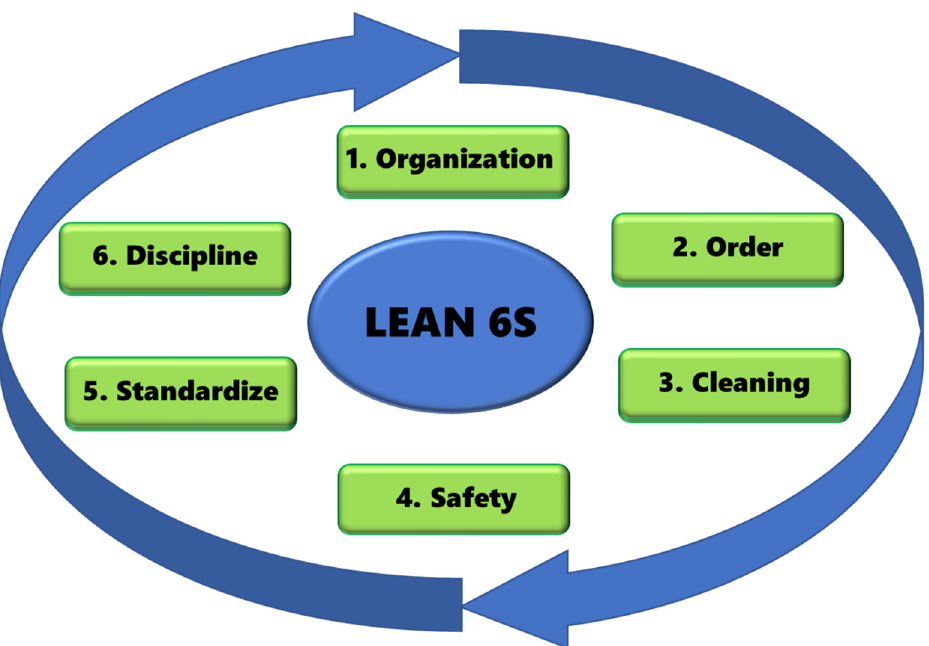
Figure 2 . Lean 6S methodology. Figure 2. Lean 6S